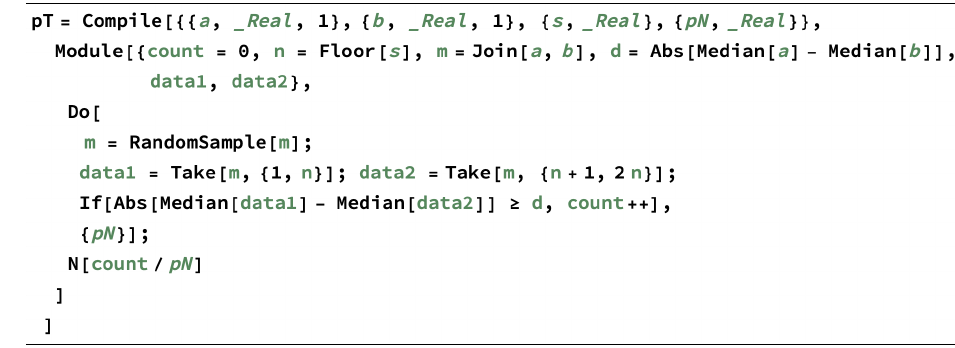
Figure 2. The P-test in the Wolfram language. Algorithm 1 P-test for two